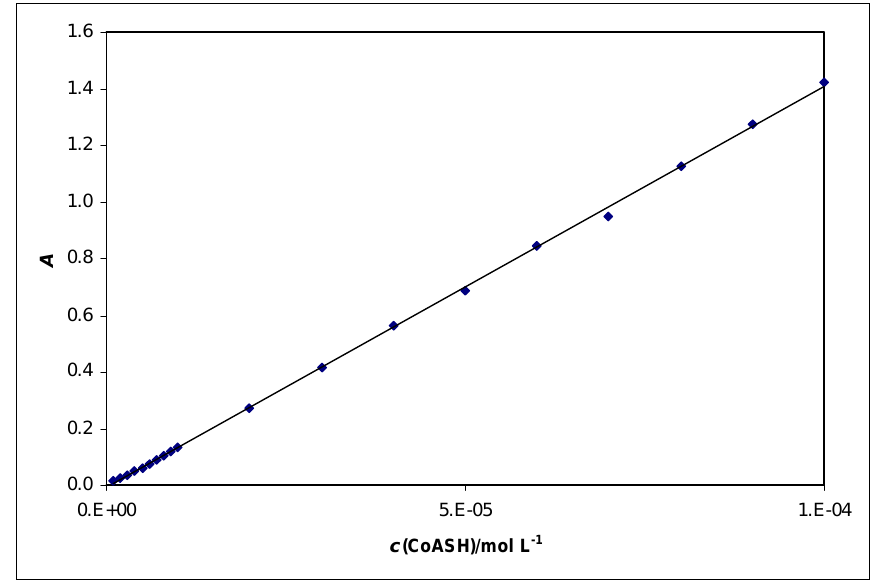
Figure 5. Linear response range of CoASH in concentration range 1.0x10 -6 to 1.0x10 -4 M.